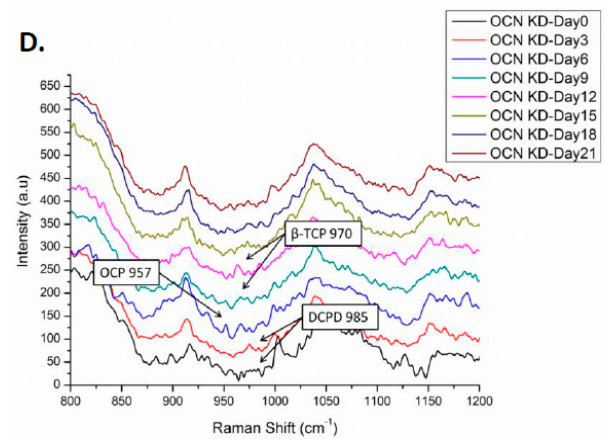
Figure 4. ( A , B ) Raman spectra of the sham control group during osteogenic differentiation: ( A ) complete view from 600 to 1800 cm − 1 ; ( B ) the detail region from 800 to 1200 cm − 1 in stack diagram; ( C , D ) Raman spectra of the OCN-KD group; ( C ) complete view from 600 to 1800 cm − 1 ; ( D ) the detail region from 800 to 1200 cm − 1 in stack diagram.